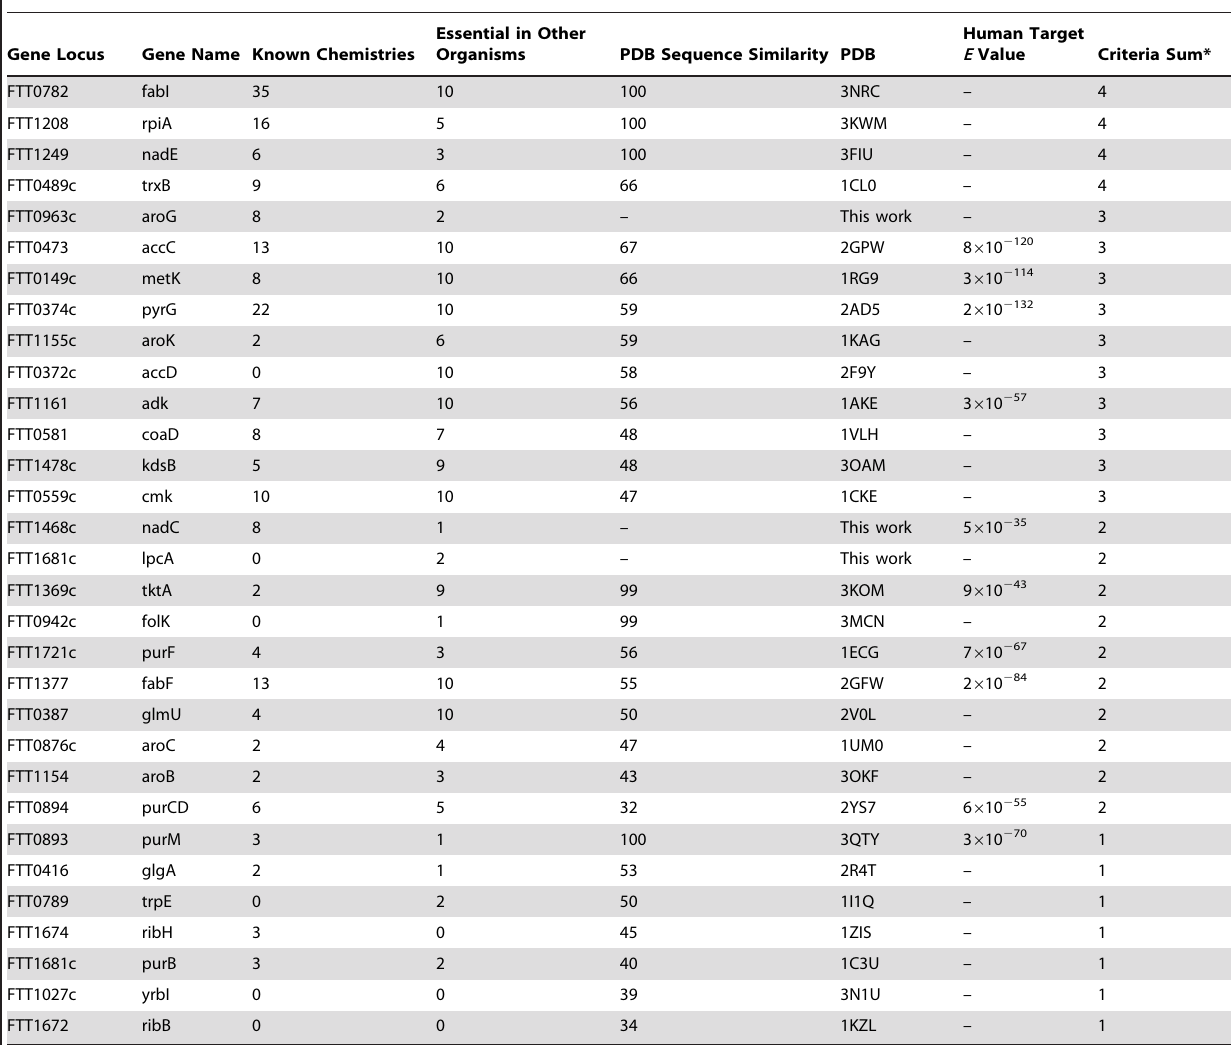
Table 1. Evaluation for selecting druggable targets.